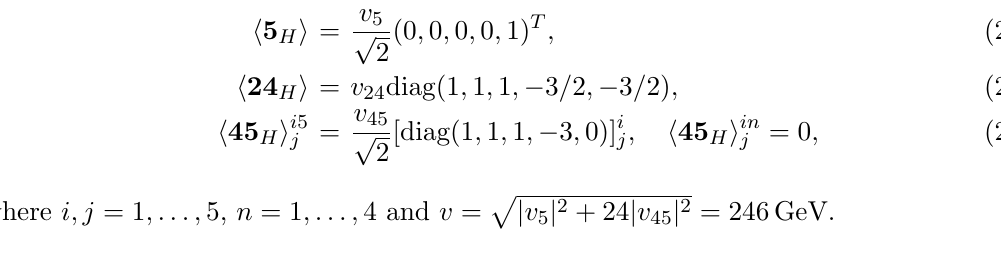
Table 1 . Field content and their representation assignments under the gauge group SU(5), modular S 4 and their weights k I in the model. The VEVs of the scalars are listed as the follwing